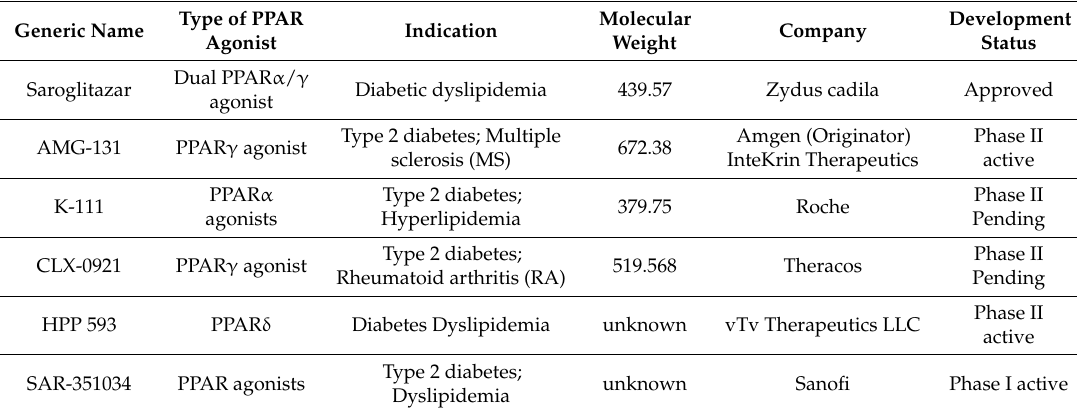
Table 6. Drugs of PPAR ligands for treatment of diabetic associated complications in market or clinical